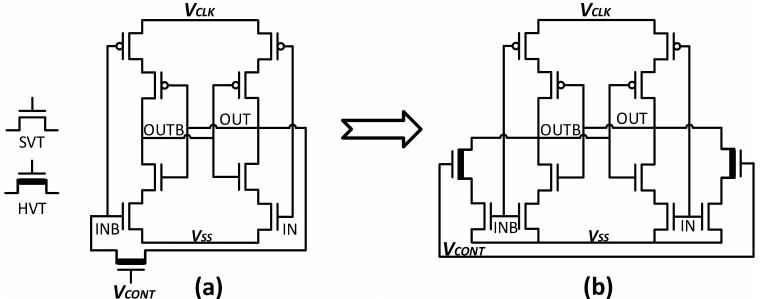
Figure 14. Leakage-controlled delay cell ( a ) Conventional single branch. ( b ) Modified two leakage control Branches.